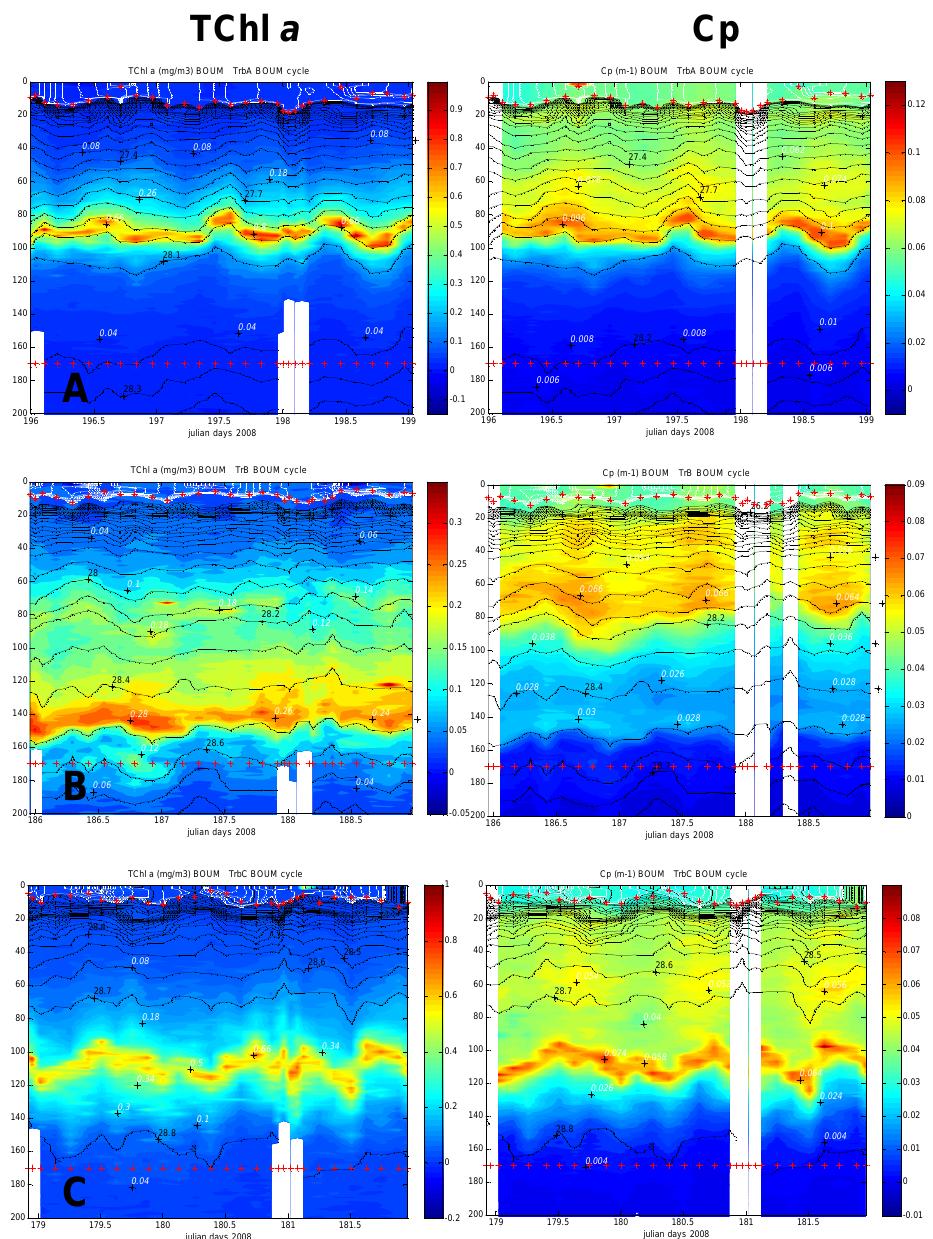
Fig. 11. Temporal sections between 0–200m depth for T chl a (mgm − 3 ) and for the optical attenuation coefficient Cp (m − 1 ) for the particles at the LD stations A (top), B (middle) and C (bottom). The dates on the x-axis are in 2008 Julian days, and the dates of the profiles are indicated by red crosses near 170dbars. The red stars indicate MLD 0 . 03 . Some values are indicated in white. The fine black lines are the isopycnals drawn each at 0.1kgm − 3 intervals. The white lines in the upper part of each panel are the isopycnals drawn each at 0.01kgm − 3